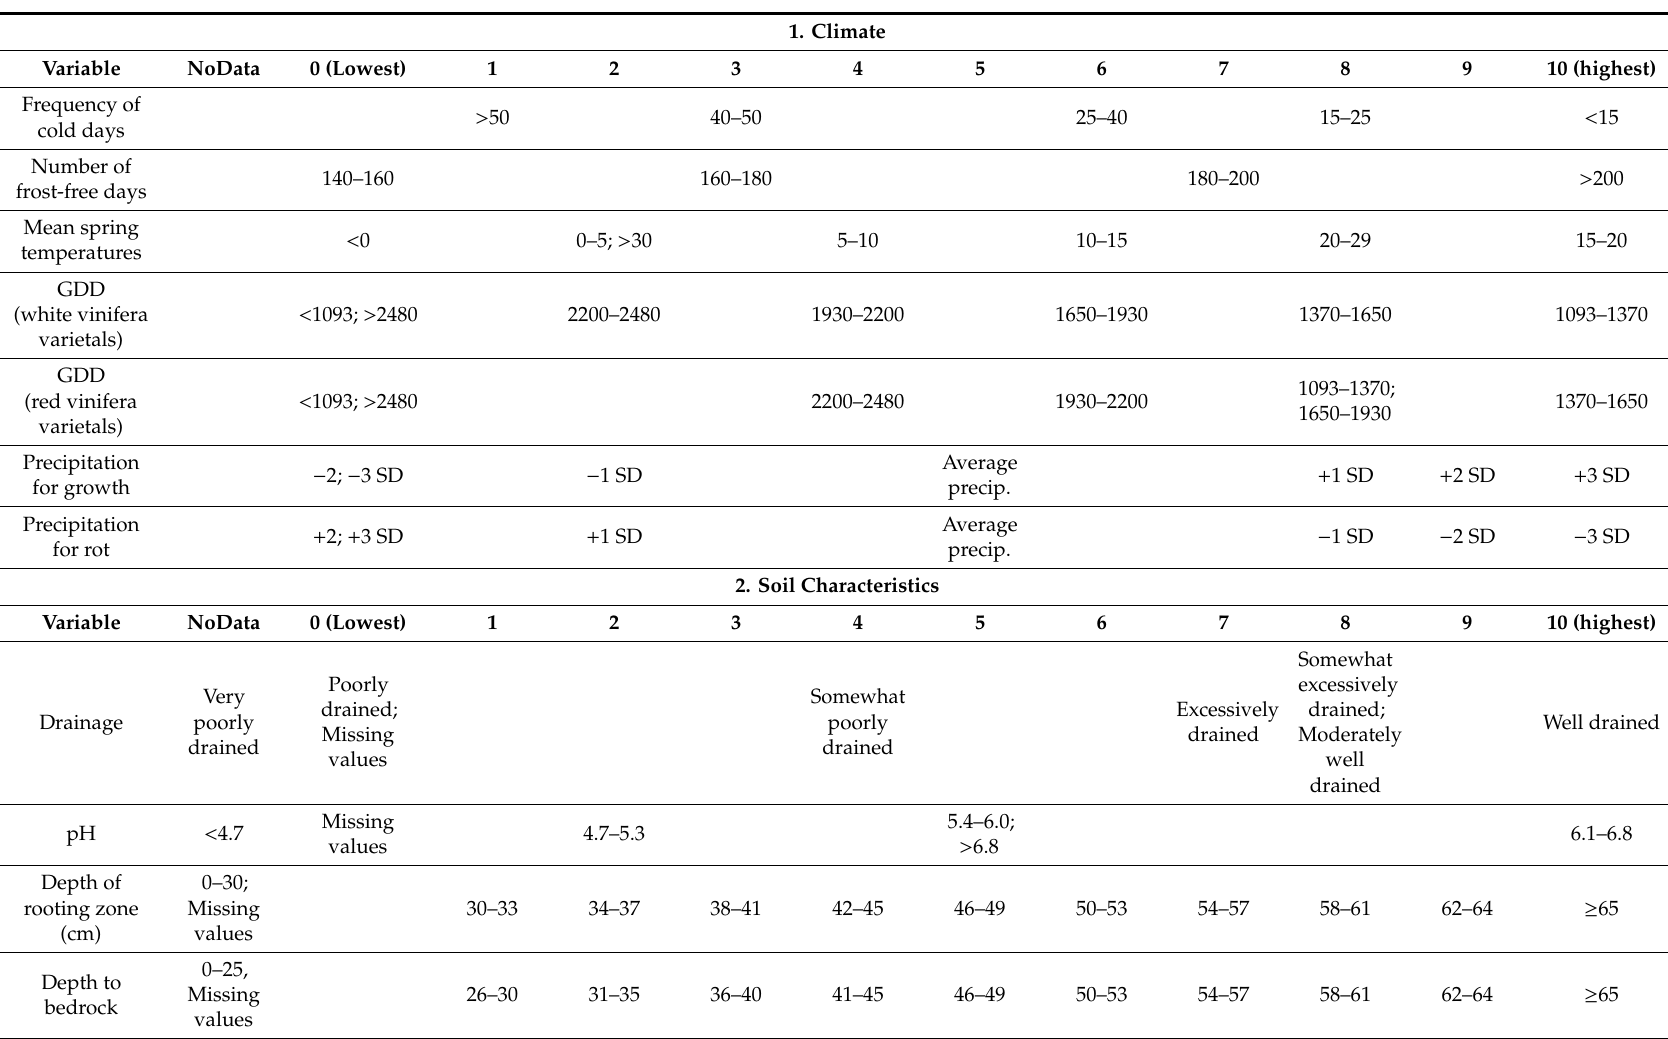
Table 2. Reclassified variables used in the land suitability evaluation (LSE)